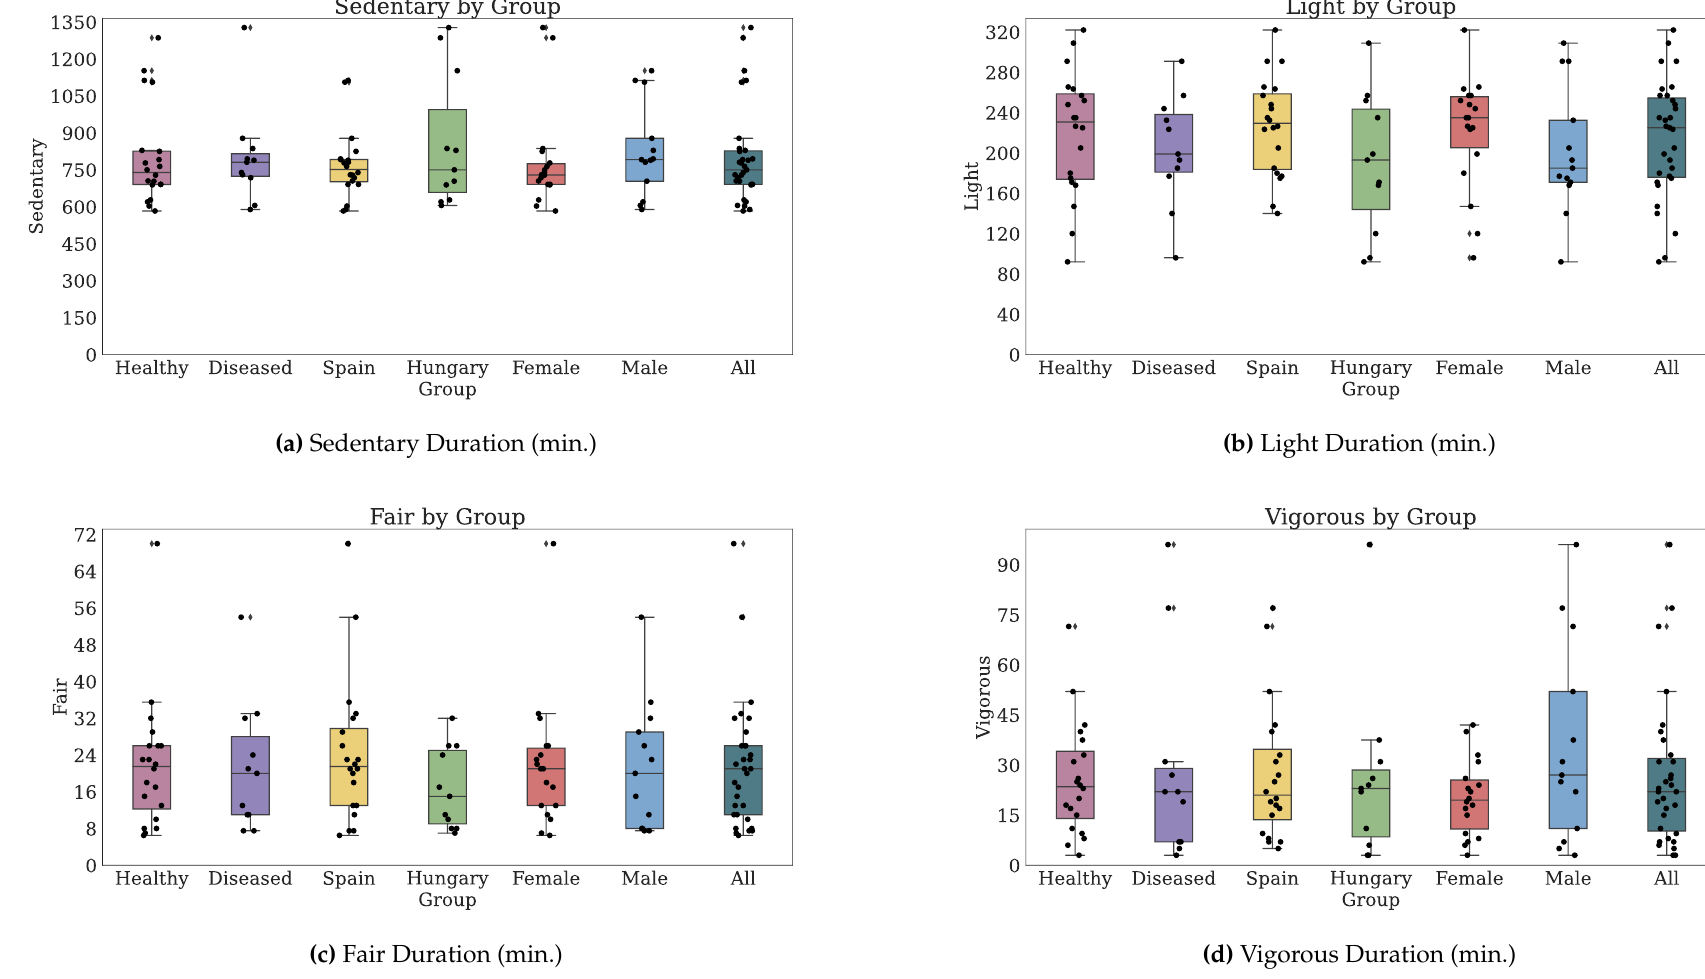
Figure 9. Median values of TechROs (Fitbit) across the entire monitoring period: physical activity (2 of 2)